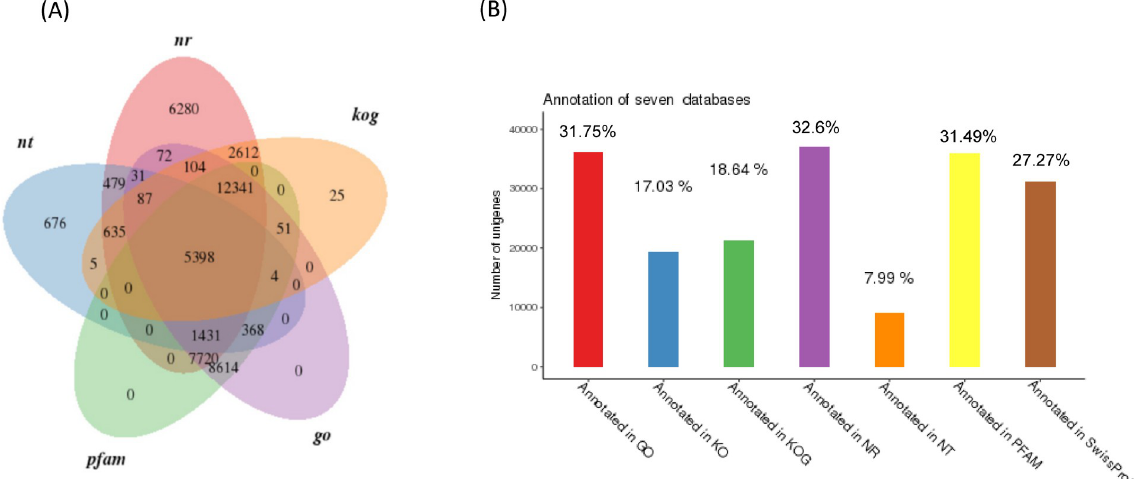
Fig 1. The number and percentage of identified unigenes based on the selected databases. (A) the venn diagram is mapped with 5 selected database annotation result. (B) the number and percentage of identified unigenes through 7 databases.